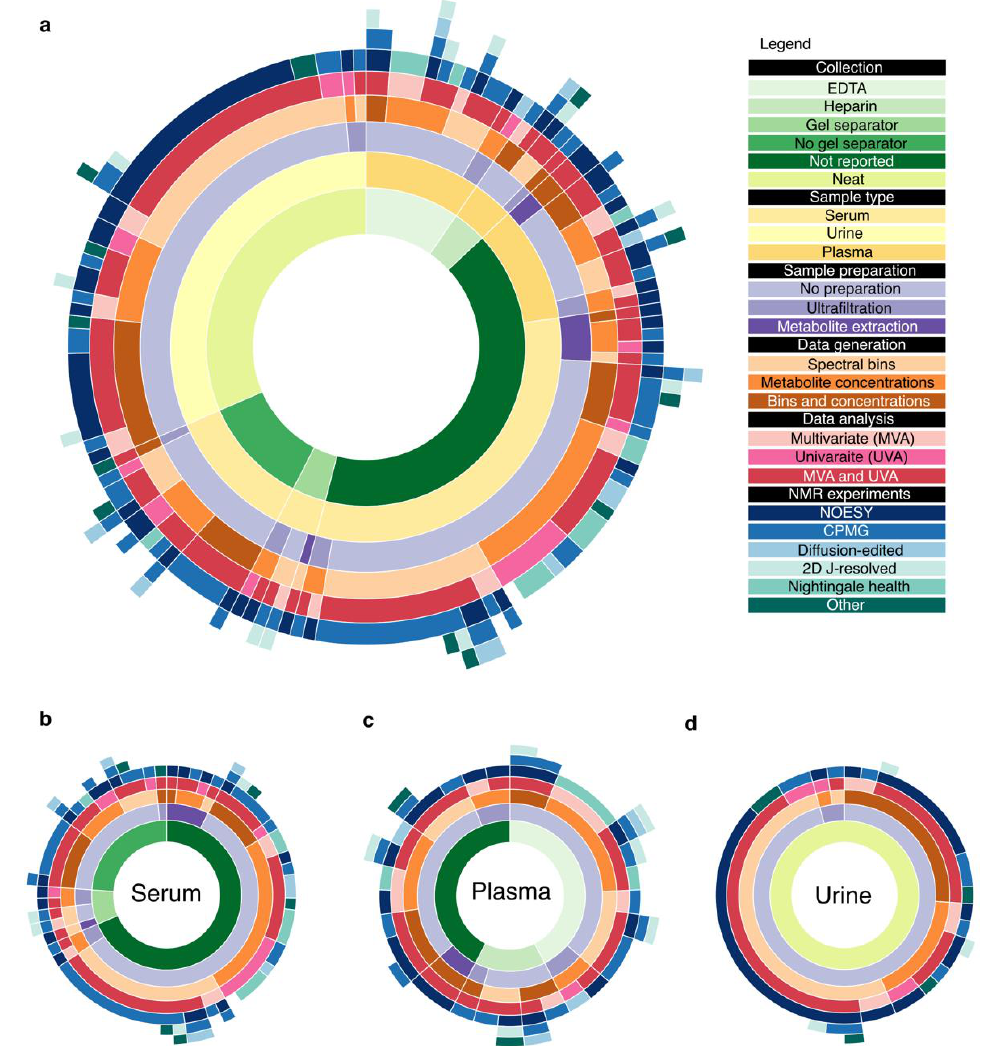
Figure 3. Sunburst charts showing the variation in workflows for NMR metabolomics. Each ring shows a step in the NMR metabolomics workflow and the segments show the percentage of studies that had used each method represented in ( a ) the whole literature search, ( b ) serum studies, ( c ) plasma studies and ( d ) urine studies only. The flavours of sunbursts can be explored interactively at https://rpubs.com/sunburstNMRMetabolomics accessed on 25 May 2022. One plasma study (Article ID: 99) that used sodium-citrate collection tube was removed in the visualization to keep the segments at a perceivable size (see Supplementary Data for the detailed